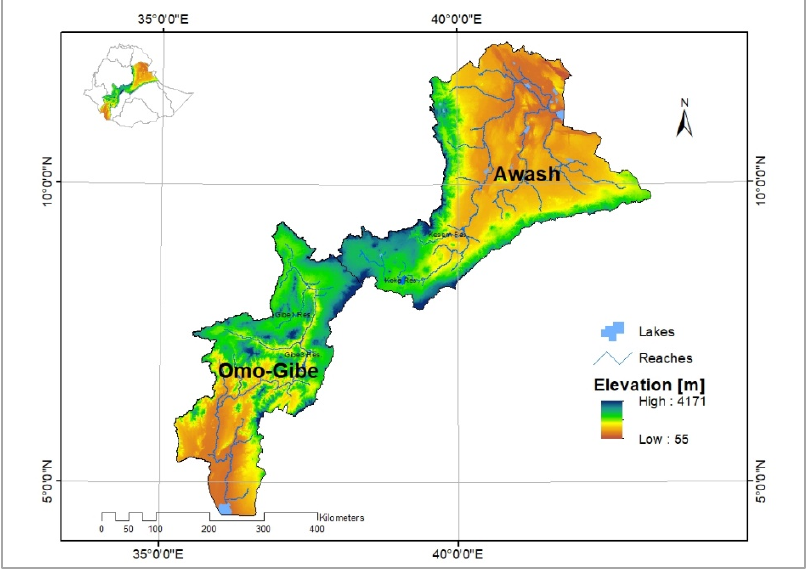
Figure 1. Location of model basins and surface aspects.